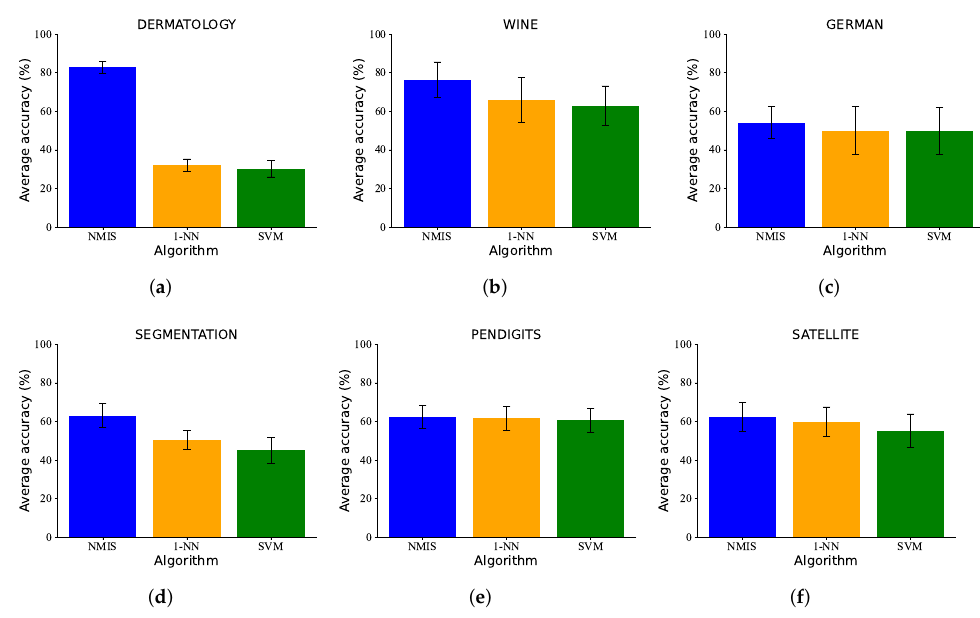
Figure 5. The one-shot learning results (%) of NMIS, KNN and SVM on ( a ) DERMATOLOGY, ( b ) WINE, ( c ) GERMAN, ( d ) SEGMENTATION, ( e ) PENDIGITS and ( f ) SATELLITE datasets.